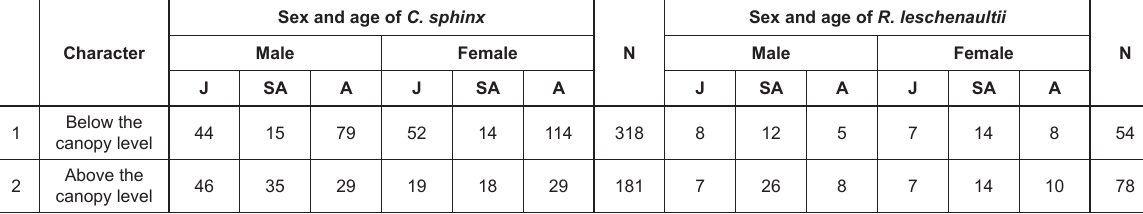
Table 5. Number of bats captured at above and below the canopy level